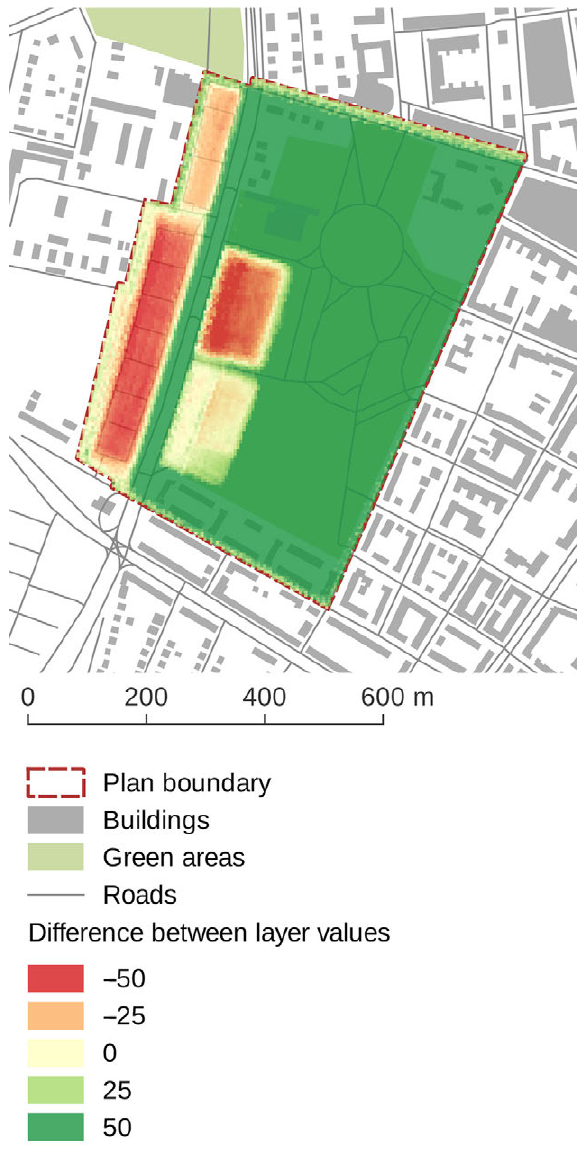
Fig. 4. Agreement-disagreement map. The map was created by calculating the difference between two aggregate maps with polygons representing preferences: one in favour of the preservation of current function, and the other in favor of function change. Negative values on the map represent areas where views in favour of function change dominate, positive values represent areas where views in favour of function preservation dominate. Sources: topographic data © OpenStreetMap contributors; thematic data collected in the Kasprowicz Park case